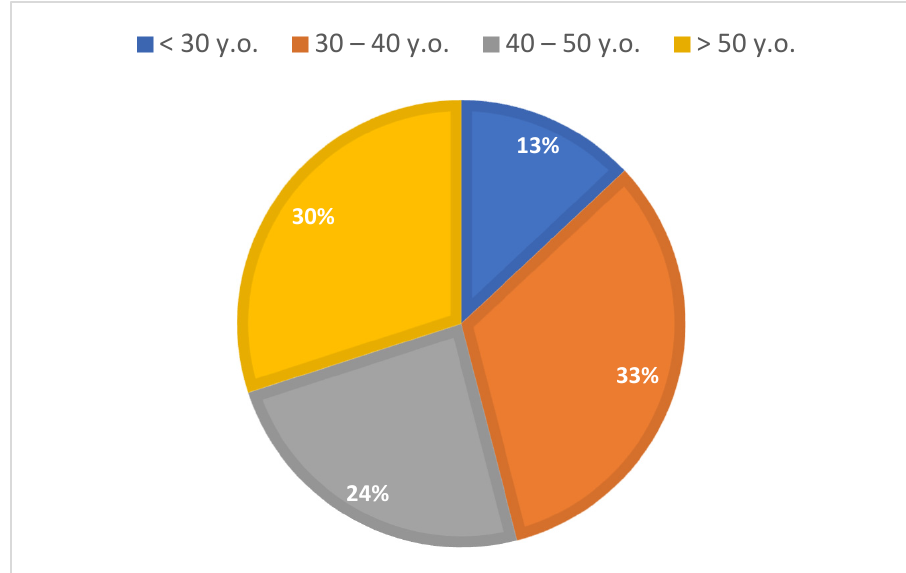
Figure 1. Distribution of the study group according to age.